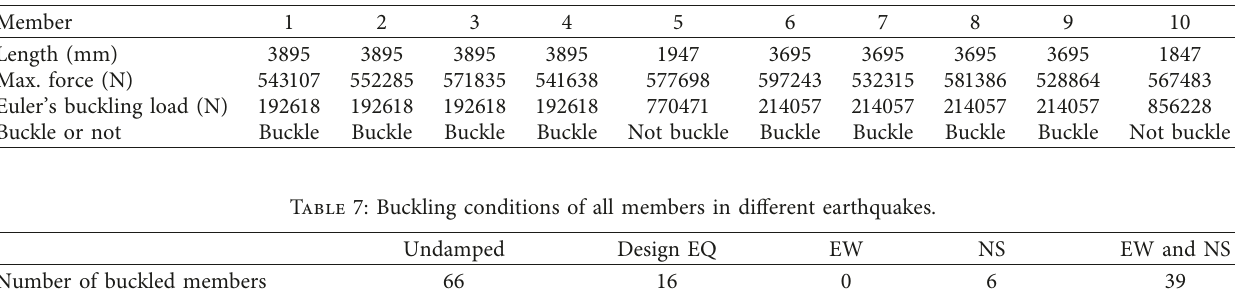
Figure 35: Maximum forces and Euler’s buckling forces for each Table 6: Buckling conditions of ten selected members under the undamped condition.